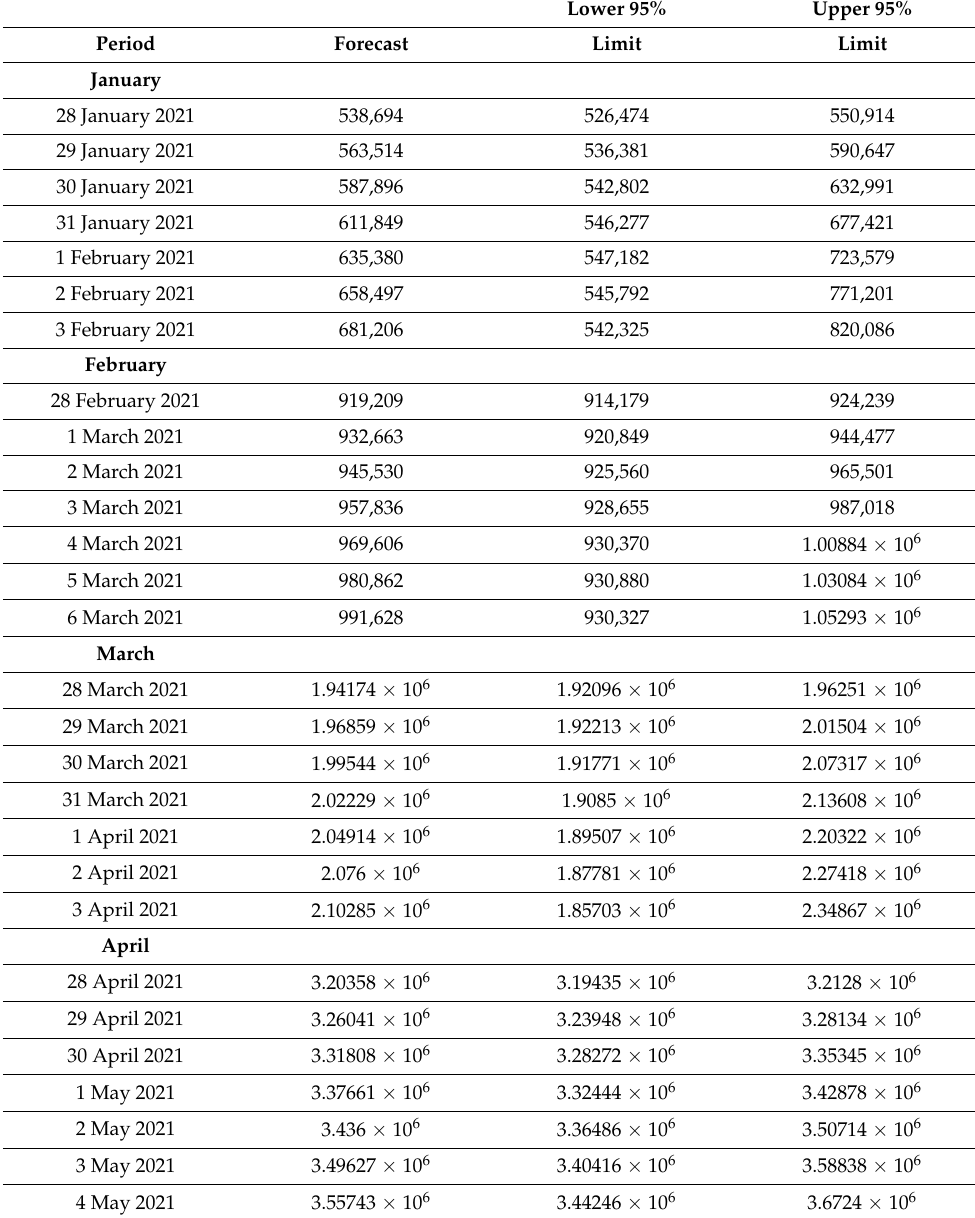
Table 3. Prediction of vaccinated individuals against COVID-19 per month and total for the next week according to our ARIMA with